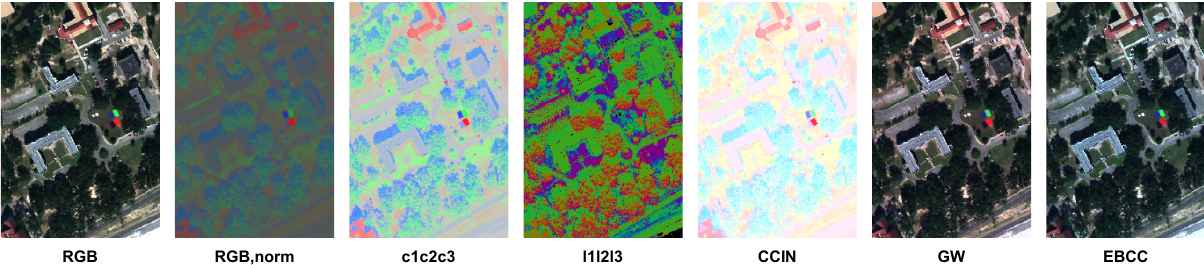
Figure 1. RGB color image and transformations derived via normalized colors, c 1 c 2 c 3 space, l 1 l 2 l 3 space, Comprehensive Color Image Normalization (CCIN), Gray-World (GW) assumption and Edge-Based Color Constancy